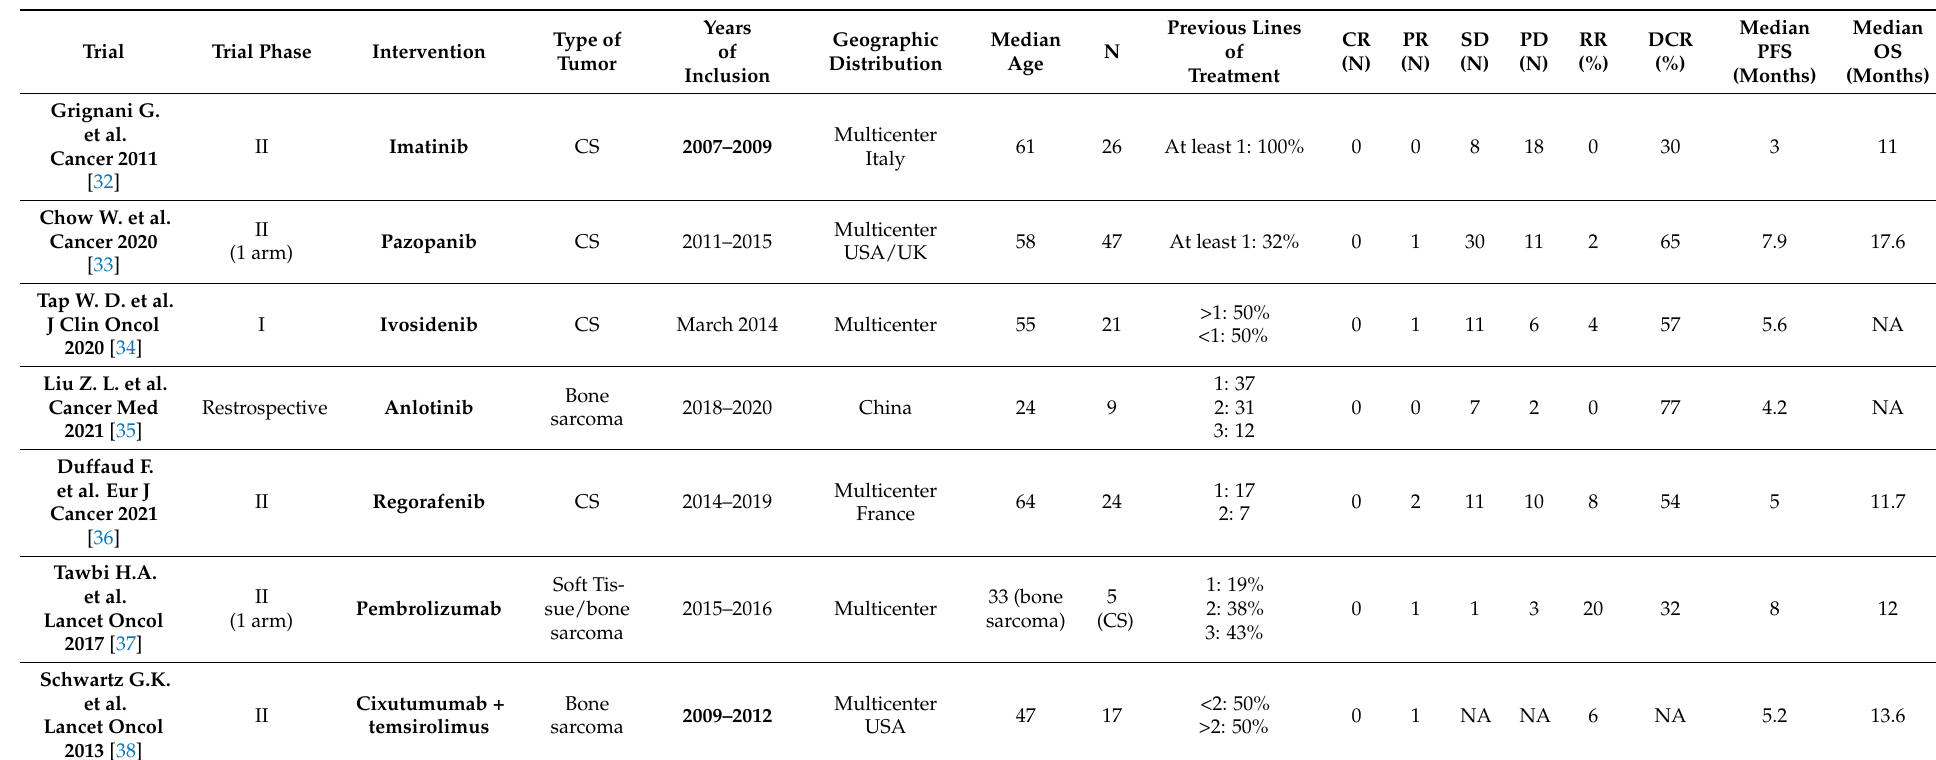
Table 3. Published clinical